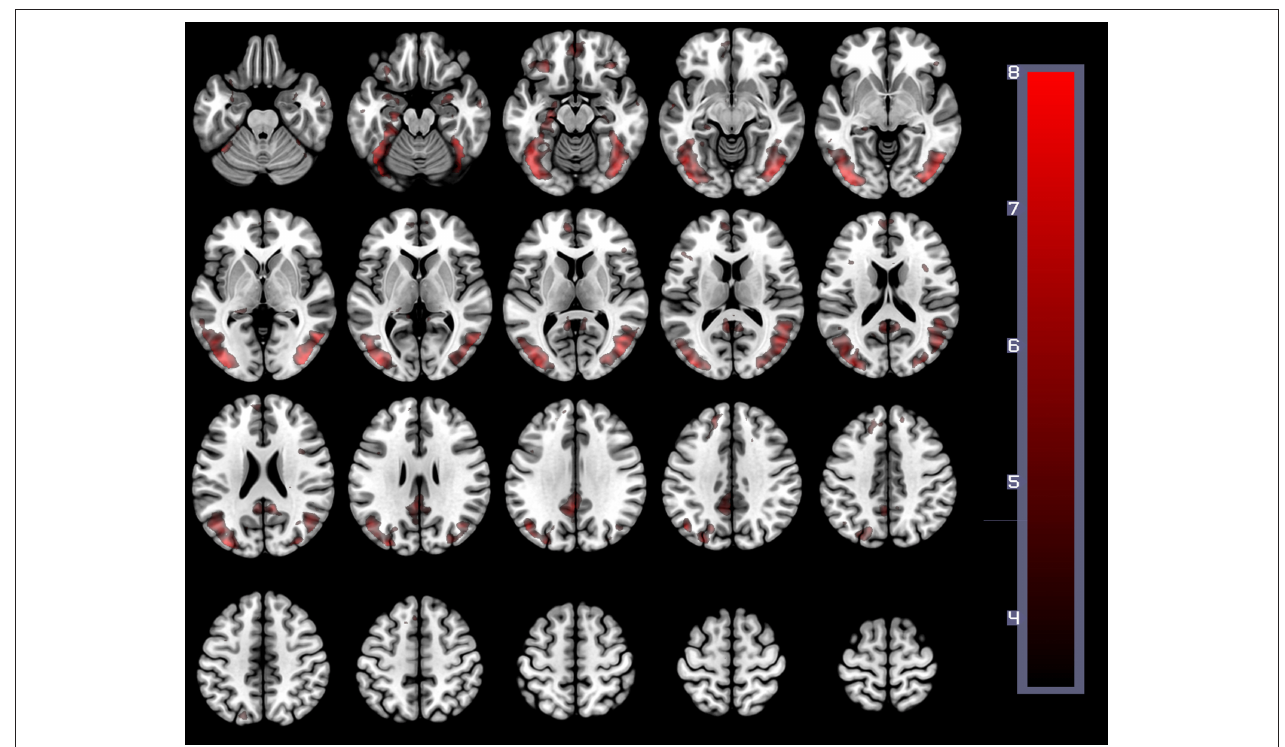
FIGURE 3 | The main effect of HWLs as compared to scrambled images. HWLs elicited activation in the putative HWL network.